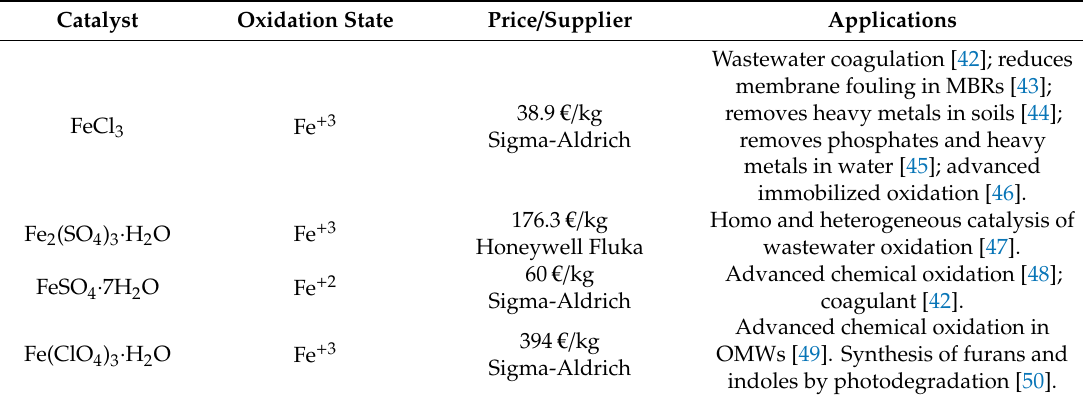
Table 4. Oxidation state and commercial price of the iron use as catalysts.